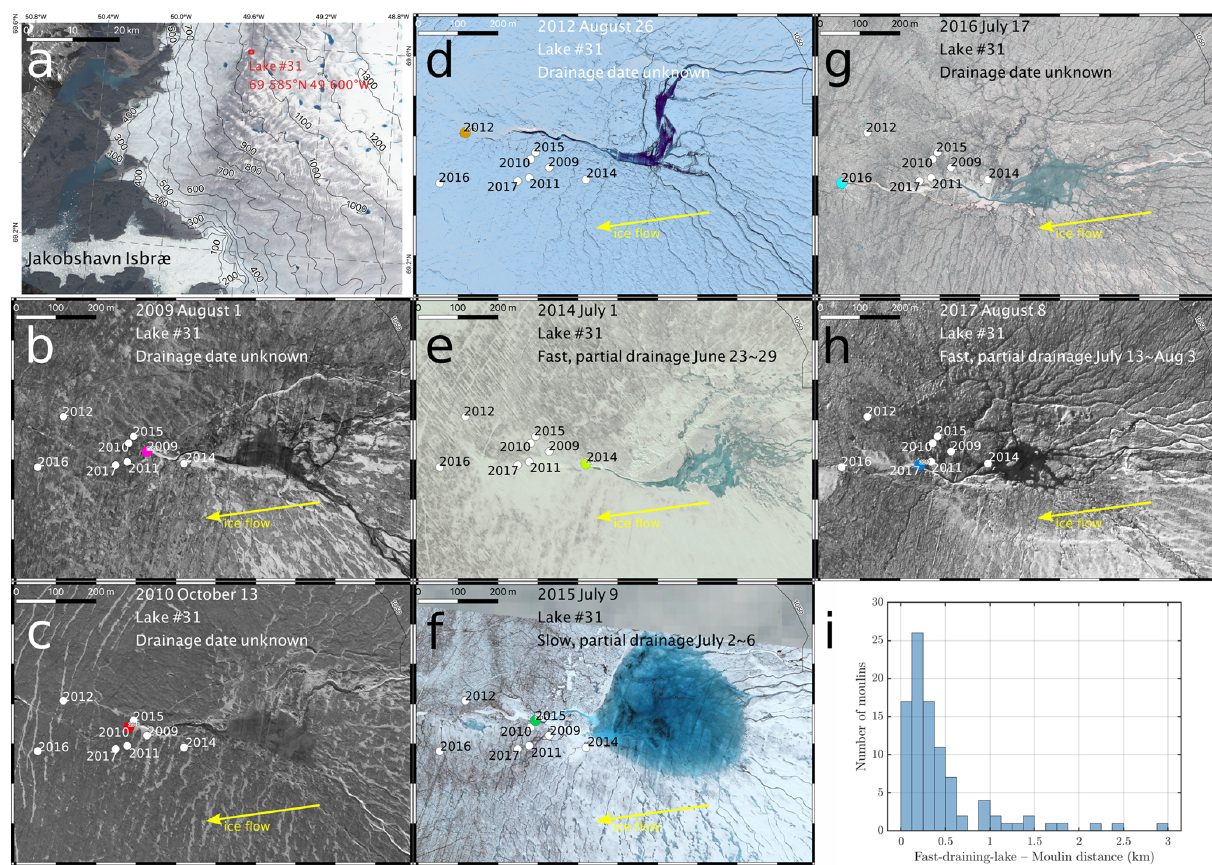
Figure 4. Map of year-by-year moulin locations for a single lake for 7 years between 2009–2017. (a) Regional setting of Lake 31, located at 69.585 ◦ N, 49.600 ◦ W in the northern part of the Pâkitsoq study area. Panel is 60km × 80km. (b–h) Seven 700km × 1000m WorldView images from 2009, 2010, 2012, and 2014–2017 showing the location of the lake-draining moulin in that year (colored dot) and in all other years (white dots). The moulin migrates over a ∼ 350m span over this 9-year period, reaching as far as ∼ 700m from the center of Lake 31. Lake drainage date, type, and completeness are noted on each panel. Ice flow is from right to left (east to west) at ∼ 40m/yr (Joughin et al., 2016a, b). Scale bars show 100m segments. (i) Histogram of lake–moulin distance for all N = 95 moulins with locations identified